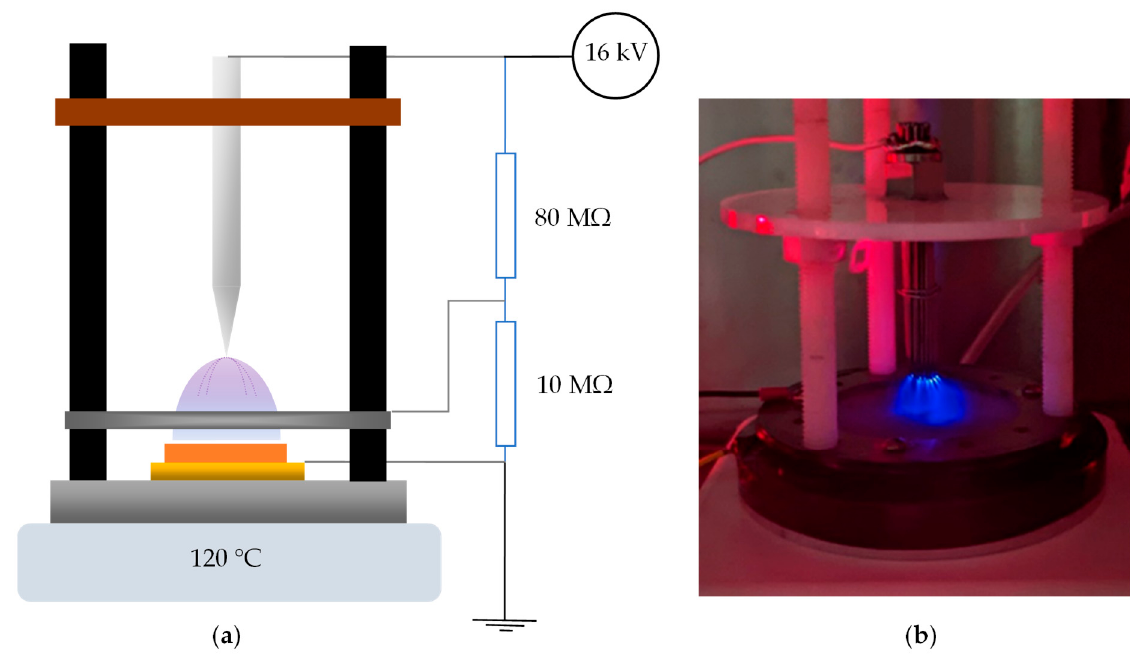
Figure 3. ( a ) Corona poling schematic; ( b ) photo of the corona poling process. A wide-range 𝑑 (cid:2871)(cid:2871) meter (APC YE2730A) was used to measure the piezoelectric co- efficient of the unsintered and sintered samples. The piezoelectric coefficient 𝑑 (cid:2871)(cid:2871) can be defined as the ratio of electric charges ( 𝑄 ) generated in response to the applied force ( 𝐹 ) when both the applied force and generated charge are in the poling